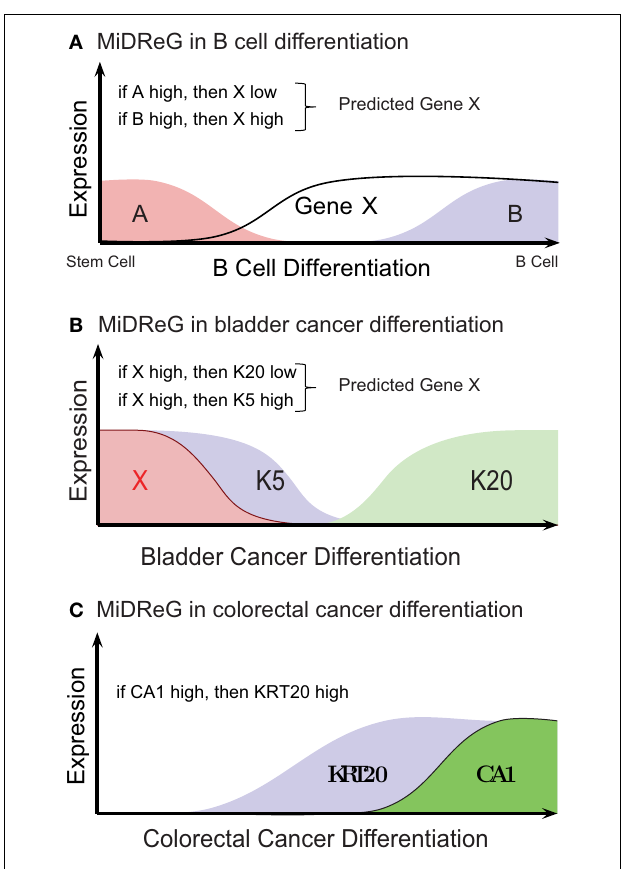
FIGURE 2 | Discovery of markers of differentiation using MiDReG algorithm. Mining developmentally regulated genes (MiDReG) is an algorithm that uses Boolean implication to predict specific markers of differentiation in normal and cancer tissues. (A) MiDReG algorithm is used to predict markers of B-cell differentiation. (B) MiDReG algorithm is used to predict markers of bladder cancer differentiation. (C) MiDReG algorithm is used to predict markers of colorectal cancer